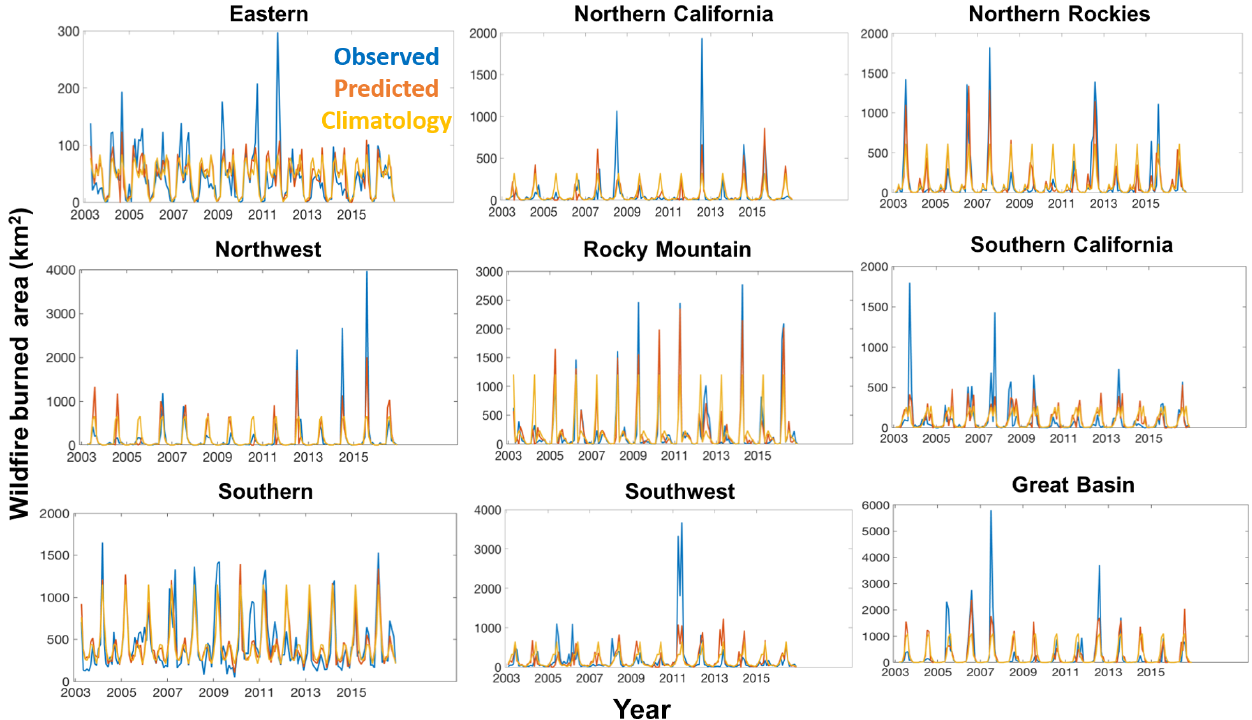
Figure 4. The ability of the regional models to predict (orange) the observed burned area (blue) is improved with the climatology (yellow), which demonstrates the ability to capture interannual variability by Geographic Area Coordination